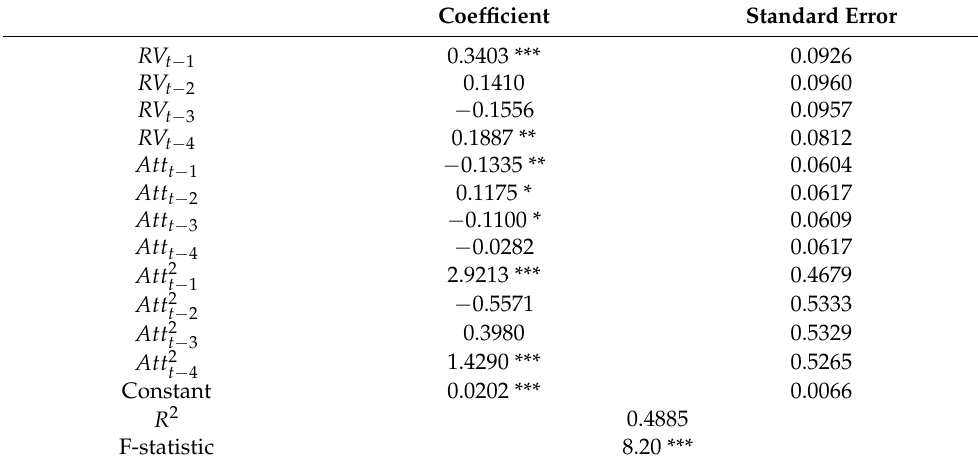
Table 16. Nonlinear relationship between realized volatility and Bitcoin attention.